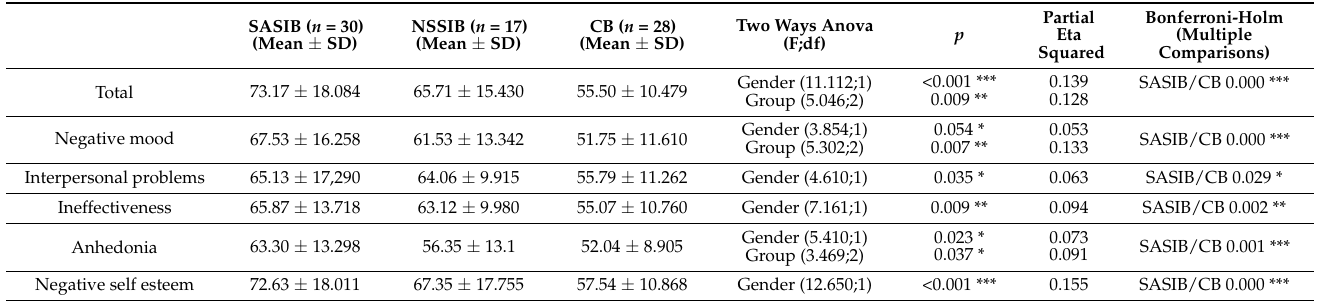
Table 3. Two-way ANOVA corrected by gender: Comparison between the three groups according to the Children’s Depression Inventory